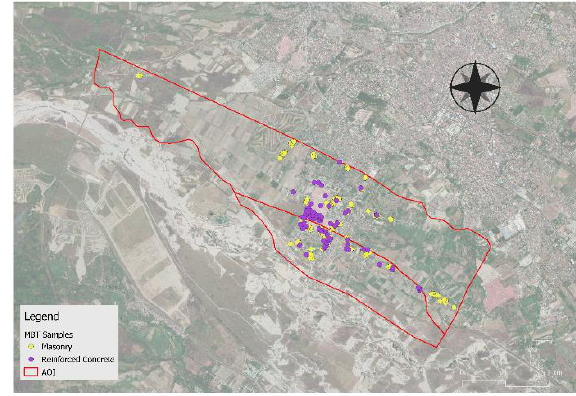
Figure 7. Map of MBT sample points collected from Street